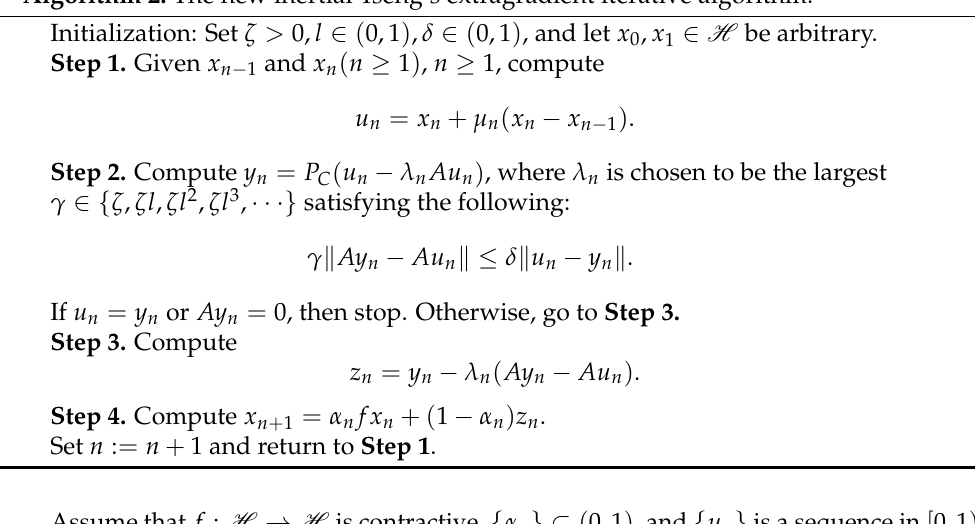
Algorithm 2: The new inertial Tseng’s extragradient iterative